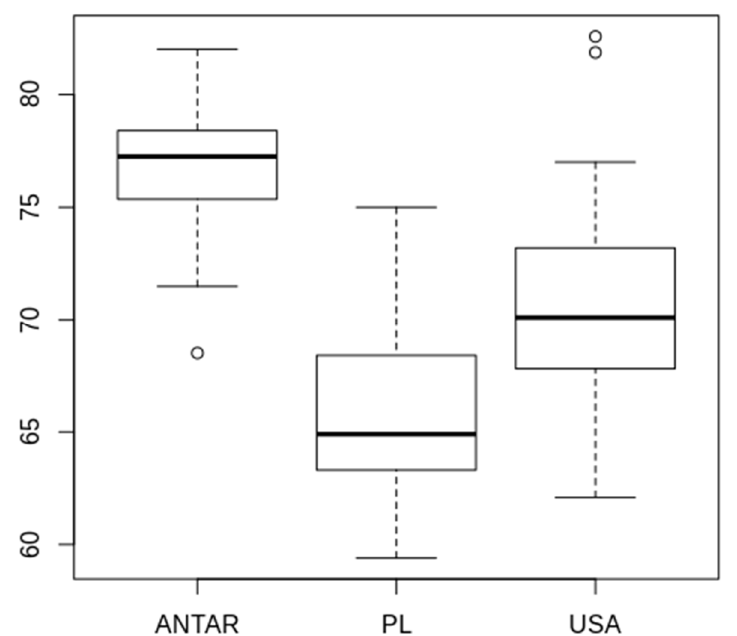
Figure 9. Differences between the studied populations of Paramacrobiotus fairbanksi Schill, Förster, Dandekar and Wolf [25] expressed by the first component of PCA performed on pt ratios of lengths of the measurements of chosen morphological structures (Antar, Antarctic; IT, Italy; PL, Poland; USA, USA). Minimum, maximum, median, first quartile, and third quartile for each population are presented.